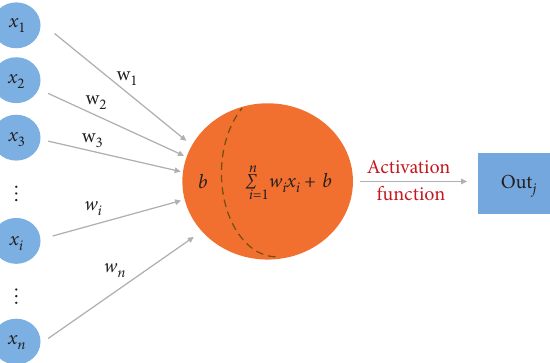
Figure 3: A simple artificial neuron